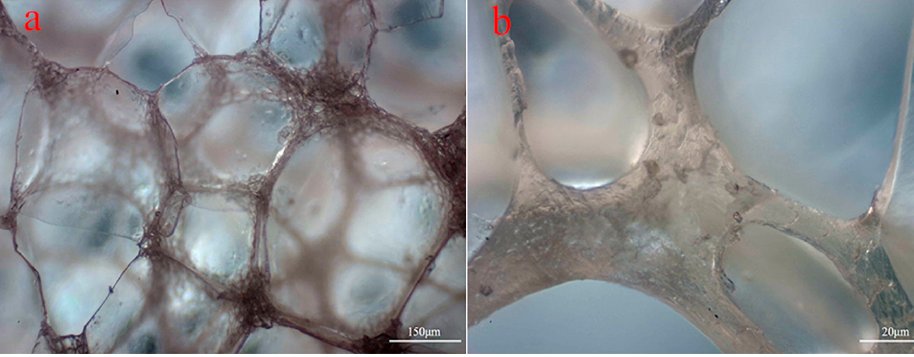
Figure 3. Optical micrographs of ( a ) H75 and ( b ) H250 foams.